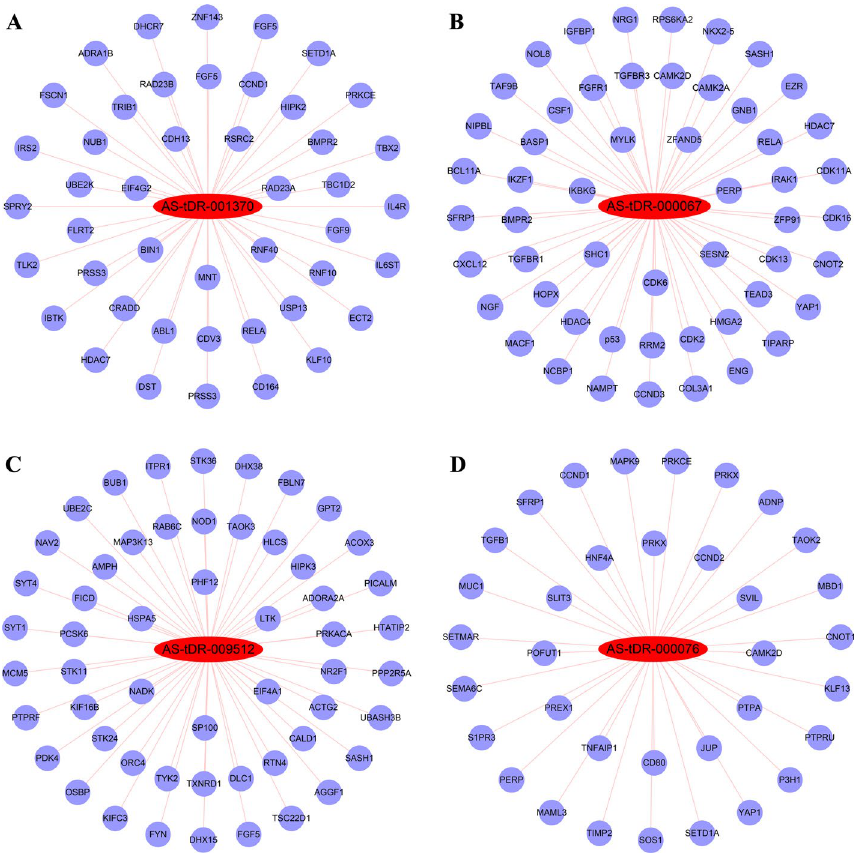
Fig. 2 Construction of tsRNA–promoter interaction networks. Subnetworks of A AS‑tDR‑001370, B AS‑tDR‑000067, C AS‑tDR‑009512, and D AS‑tDR‑000076. Red nodes indicate increased DEtsRNAs, while blue nodes indicate proliferation‑related genes containing target